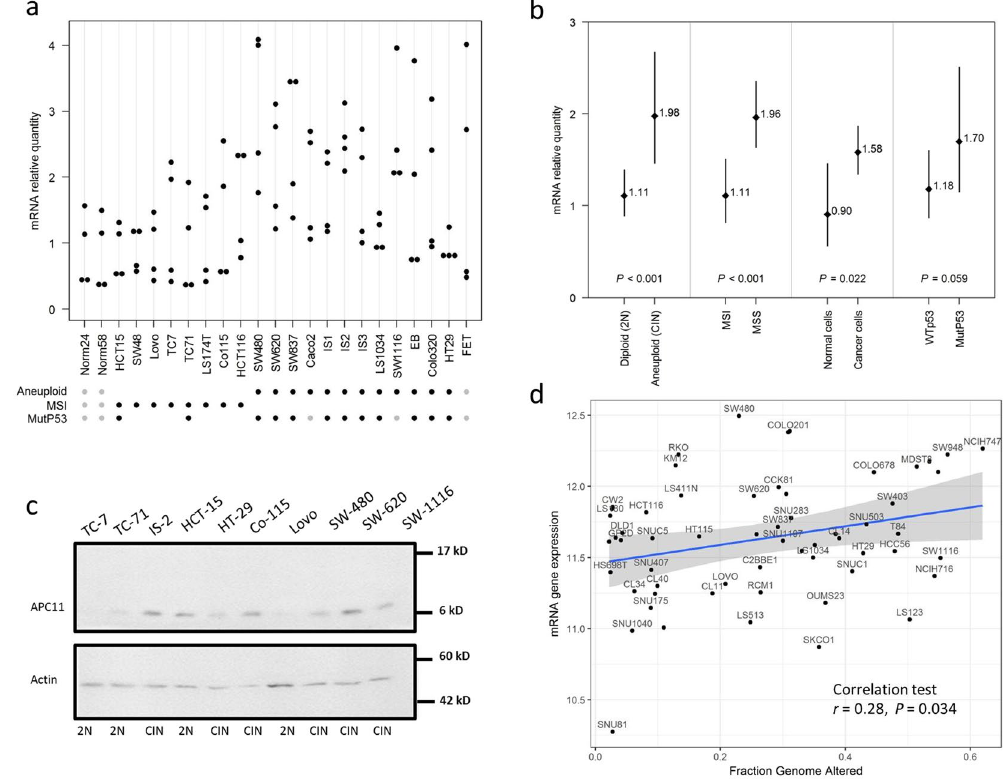
Figure 2. APC11 expression in CRC cell lines and statistical correlations with clinical and biological features. ( a ) Relative levels of APC11 mRNA were measured using real-time RT-PCR. The ratios of APC11/reference genes of four independent RT-PCR are depicted individually in the figure. Individual cell lines genetic status is indicated by dots at the bottom of the panel, grey dots indicate missing data. ( b ) The results of the statistical analysis of the individual data presented in panel (a) are displayed using a graphical representation. For each case, the number indicates the mean expression and the bars the 95% confidence intervals estimated by a random effects model. ( c ) Western blot analysis in colon cancer cell lines. The signal intensity of APC11 was normalized against actin. In the figure, are reported the cropped gel/blots for each protein evaluation. The black boxed indicate the cropped regions. Uncropped full-length gel/blots are presented in Fig. S2 (see Supplemental information). Relative protein expression was estimated using the Quantity One software (BioRad, Marnes-la- Coquette, France). ( d ) APC11 mRNA expression in 59 CRC cell lines from CCLE according to the fraction of genome altered (FGA) calculated with a threshold value of 0.3. The coefficient of correlation r is displayed with the corresponding P value; The regression line from a linear model (blue line) and its 95% confidence interval (grey area) are also displayed. Abbreviations: MSS, microsatellite stable; MSI, microsatellite